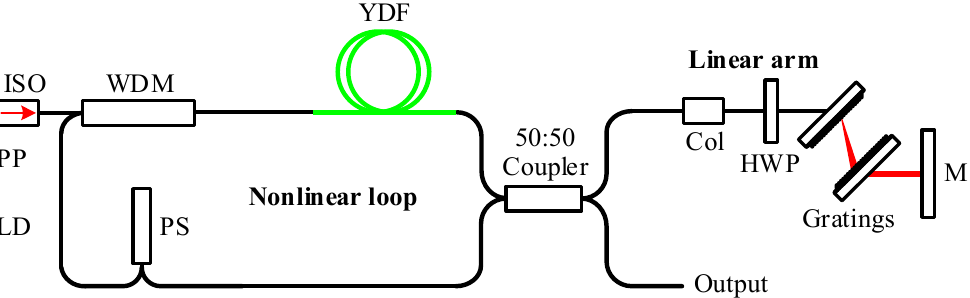
Figure 1. Schematic configuration of the laser structure. LD: 900 mW laser diode; PP: pump protector; ISO: isolator; WDM: wavelength division multiplexer; YDF: Yb-doped fiber; Col: collimator; HWP: half wave plate; M: reflect mirror; PS: phase shifter.